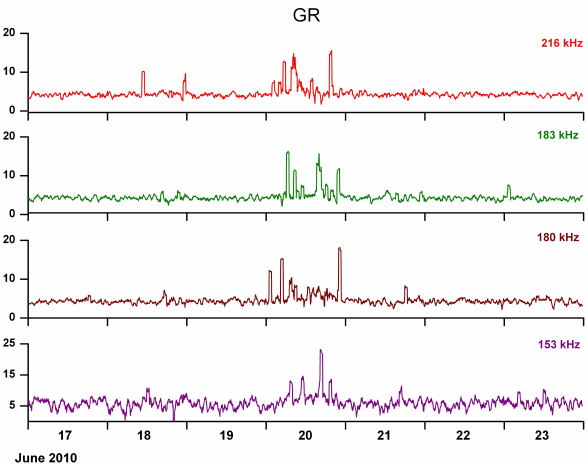
Fig. 12. In the period 1–20 November 2004, from the top read- ing downwards: D st geomagnetic index, k p geomagnetic index, the intensity (dB) of GBZ (19.58kHz), DHO (23.4kHz), NRK (37.5kHz) radio signals sampled by the IT-Ba receiver (Omnipal type). A large increase in the geomagnetic activity stands out dur- ing 7–11